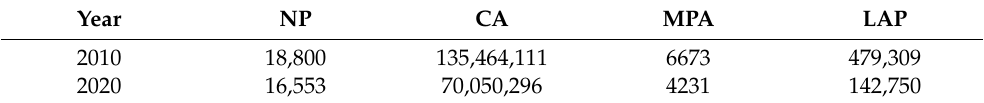
Table 3. Settlement landscape index in Jiangning District (2010, 2020).